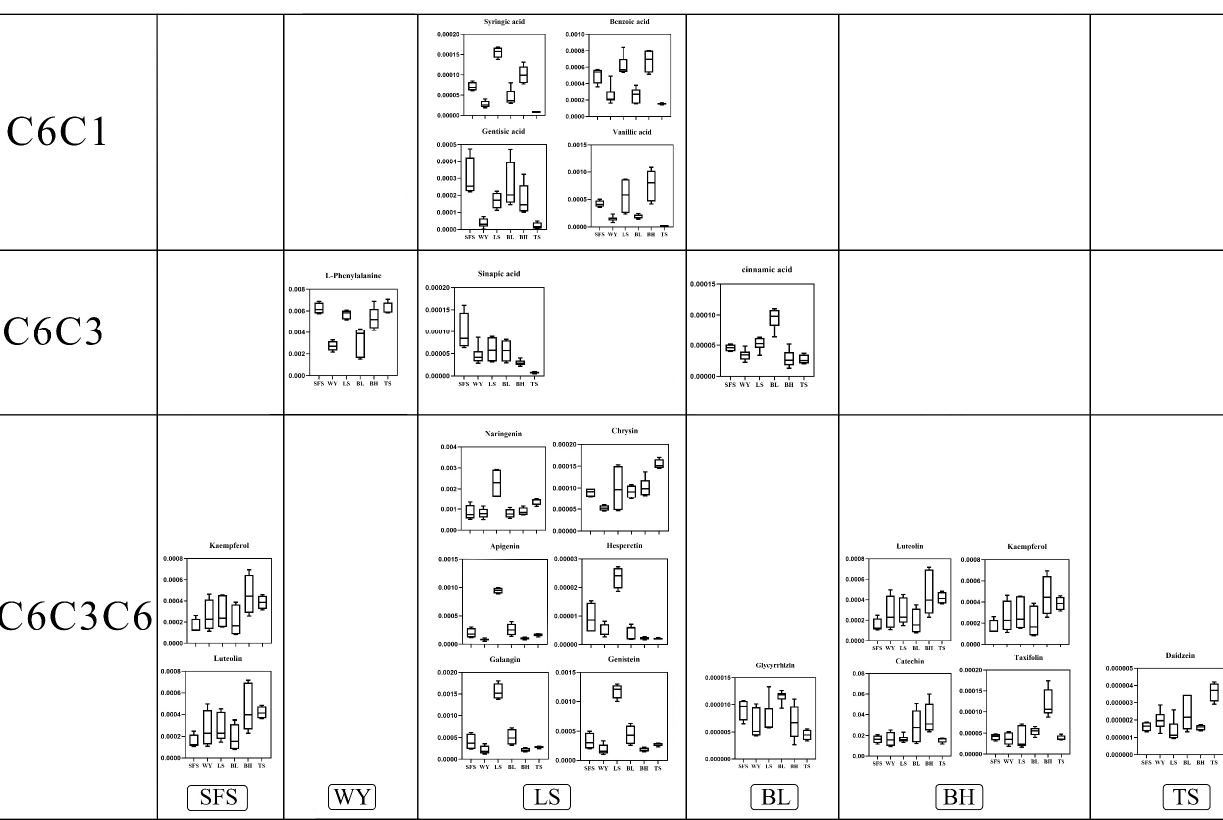
Figure 7. Box and whisker plots of significantly different metabolites. These secondary metabolites were identified through commercial standards. Classification of secondary metabolites that vary significantly at different latitudes by carbon skeleton.